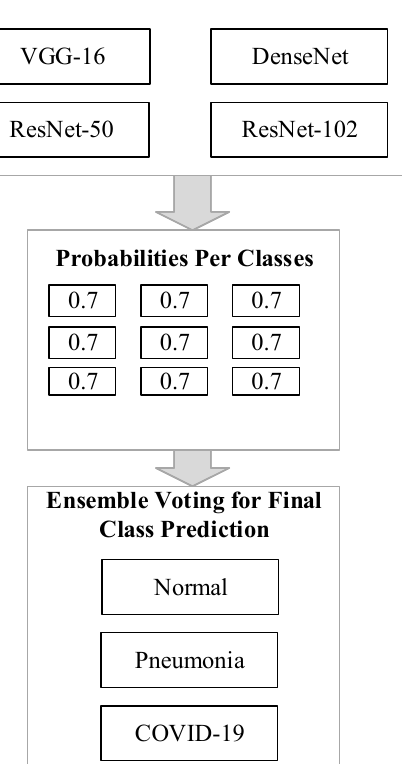
Figure 1. The architecture of the proposed model.